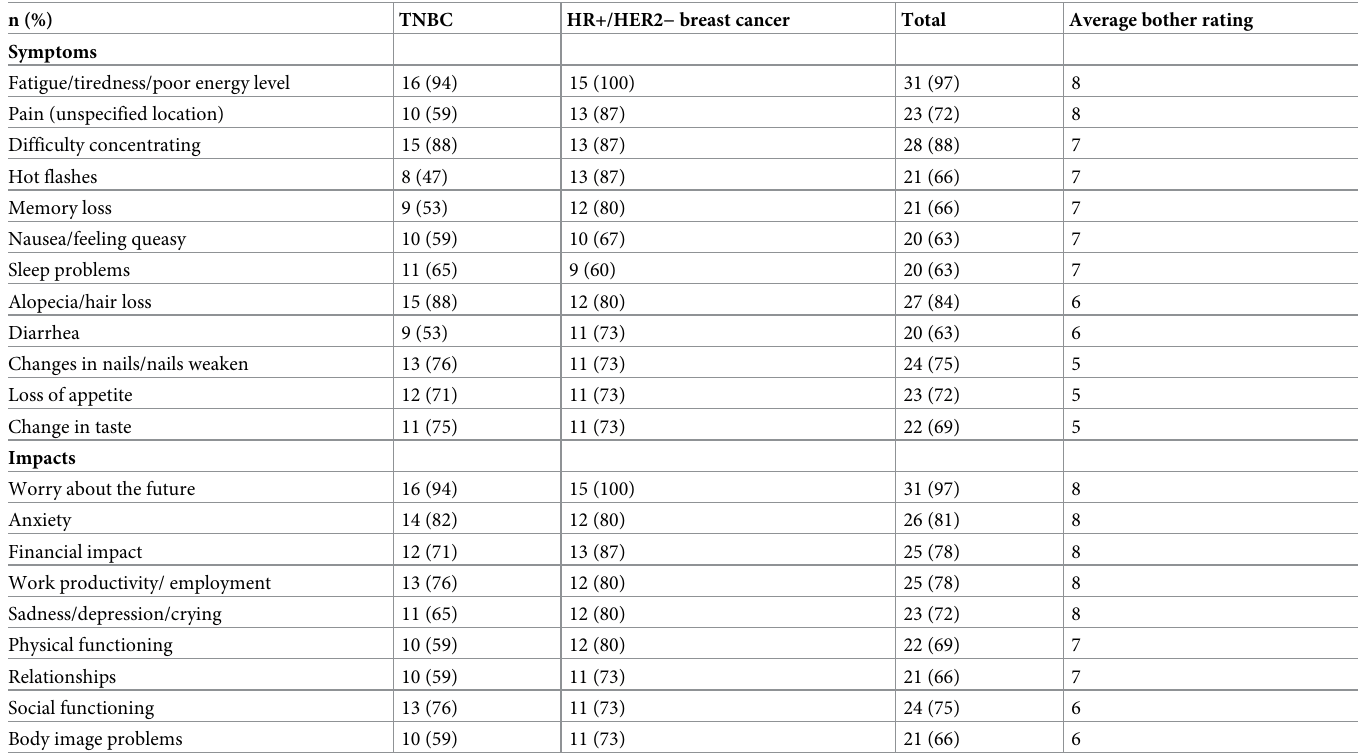
a Symptoms reported by > 60% of participants and with a rating of � 5 on the disturbance scale (0 = not bothersome; 10 = extremely bothersome). HR+/HER2 − BC, hormone receptor-positive/human epidermal growth factor receptor 2-negative breast cancer; TNBC, triple-negative breast